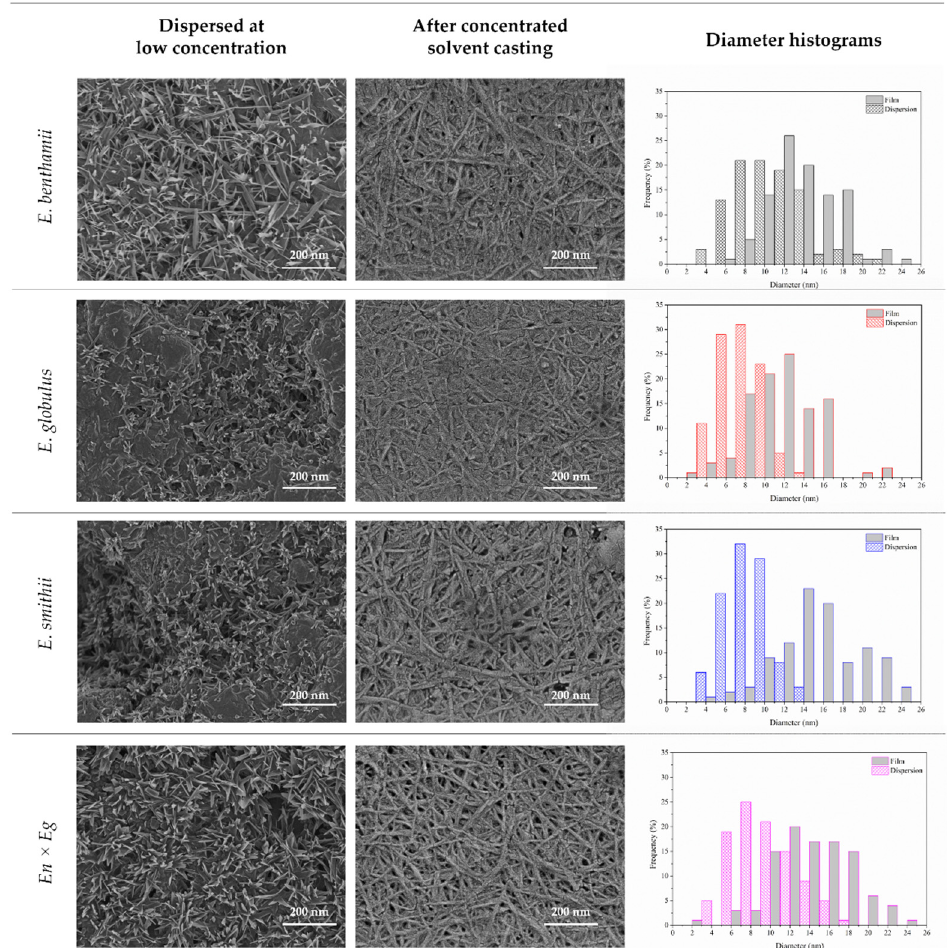
Figure 1. Surface electron micrographs and diameter distribution of the CNCs obtained from the different eucalyptus species.